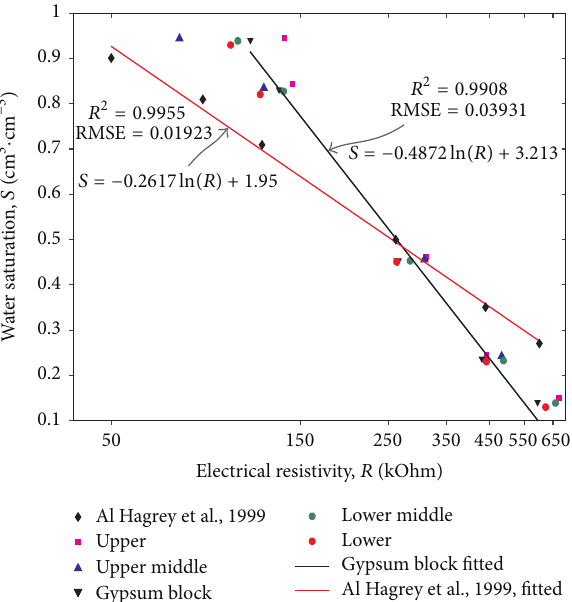
Figure 2: Calibration of the water saturation versus electrical resistivity (gypsum block) determined through the sensors used in this study compared to the results of a similar calibration obtained by Al Hagrey et al.